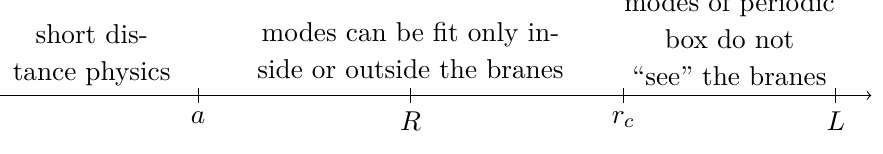
Figure 3 . Different scales of the system and their